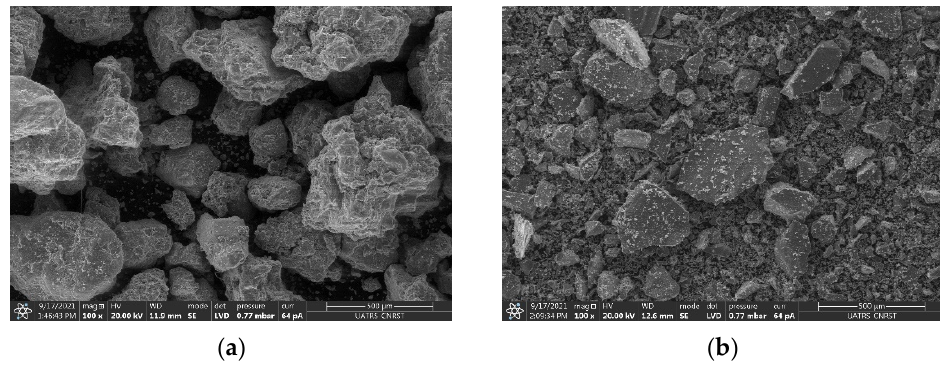
Figure 5. Scanning electron microscopy of ( a ) red earth powder, and ( b ) glass powder.